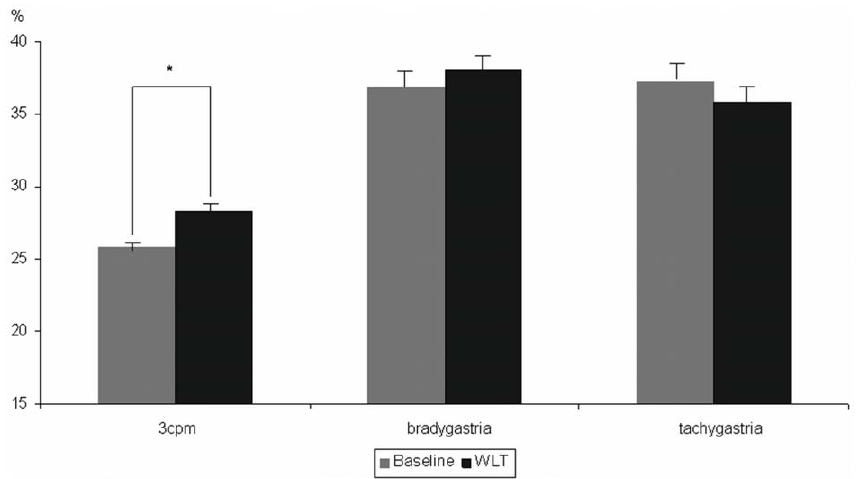
Figure 1. Activity of the electrogastrogram (%3 cpm, %bradygastria, %tachygastria) during baseline and during/after water load test (*: p , .05); total power was calculated as a sum of the spectral estimates from 1–10 cpm, percentage of total power was calculated for the bradygastria (1–2.5 cpm) = %bradygastria, normogastria 3 cpm (2.5–3.5 cpm) = %3 cpm, and tachygastria (3.75–10 cpm) bands = %tachygastria.